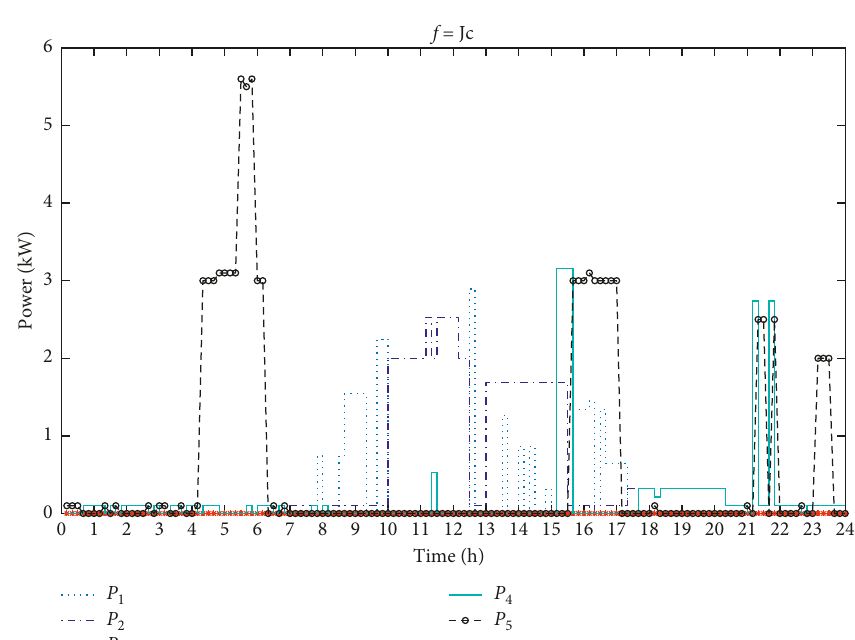
Figure 5: Power dispatch of the new design in case (ii).